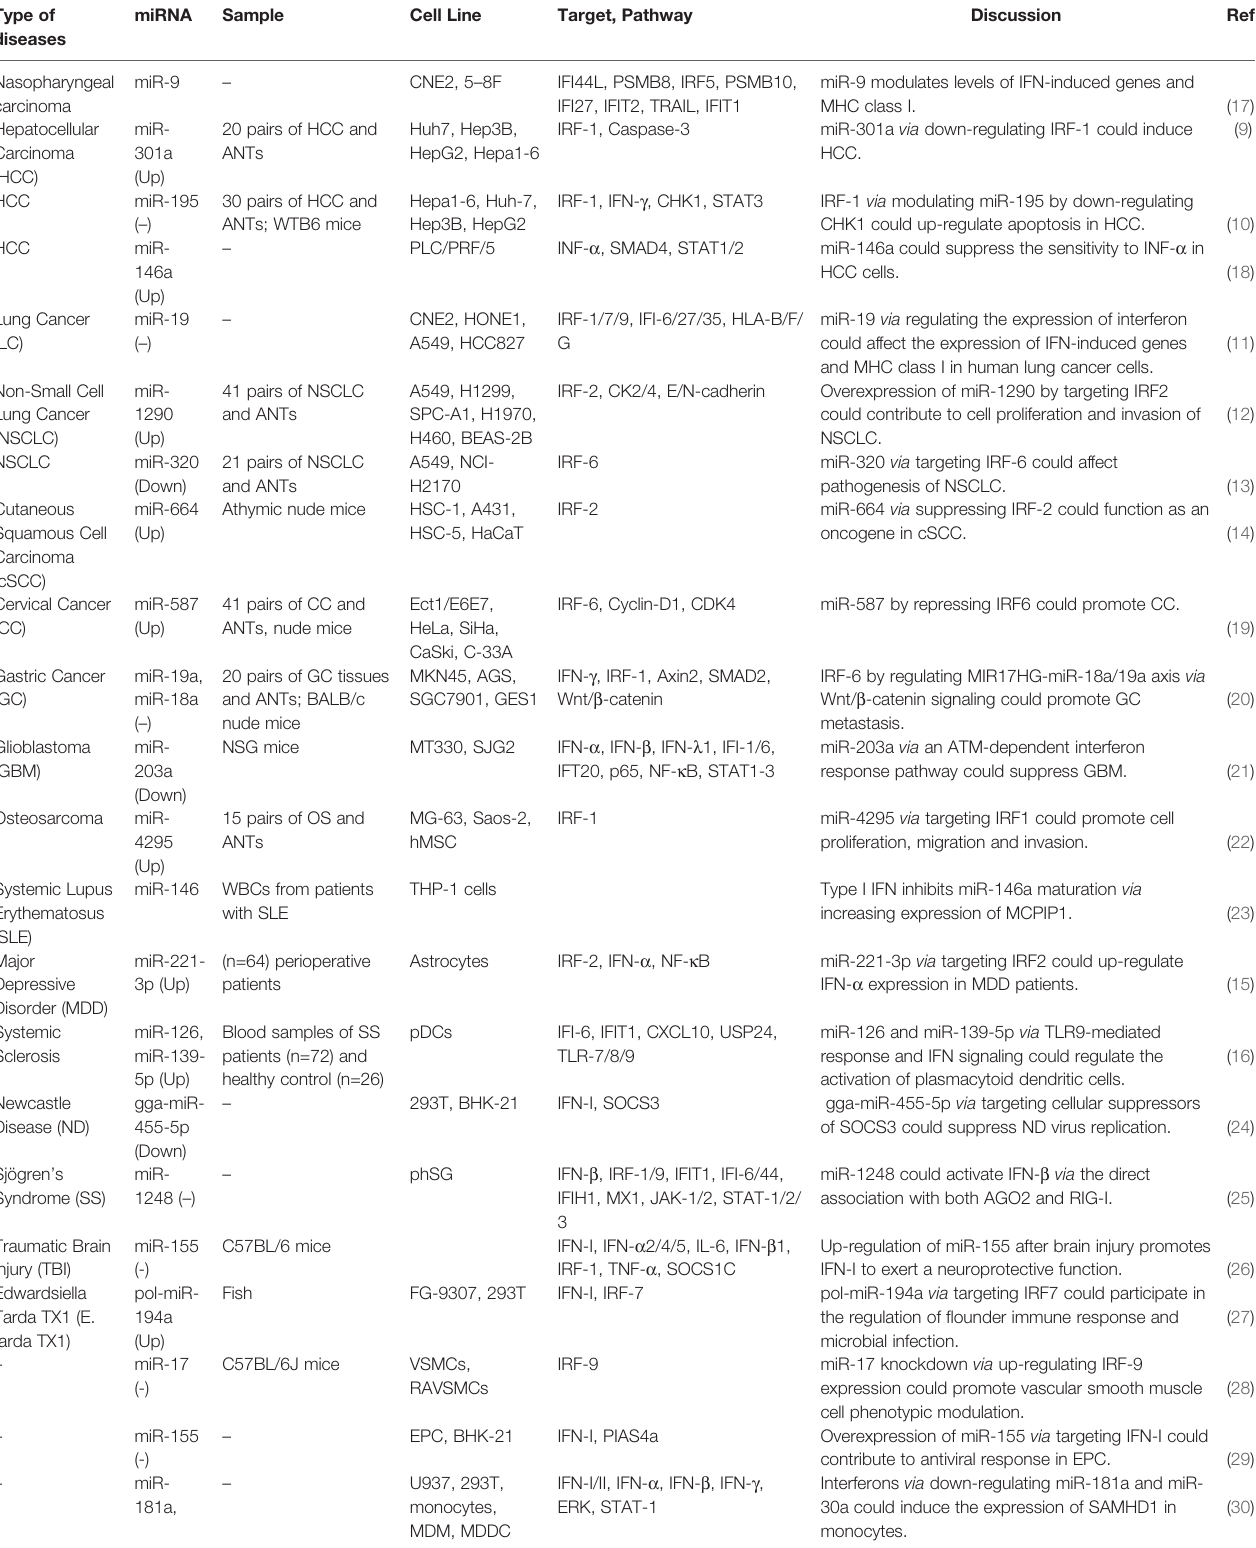
TABLE 1 | The effects of miRNAs on IFN signaling (ANT, adjacent normal